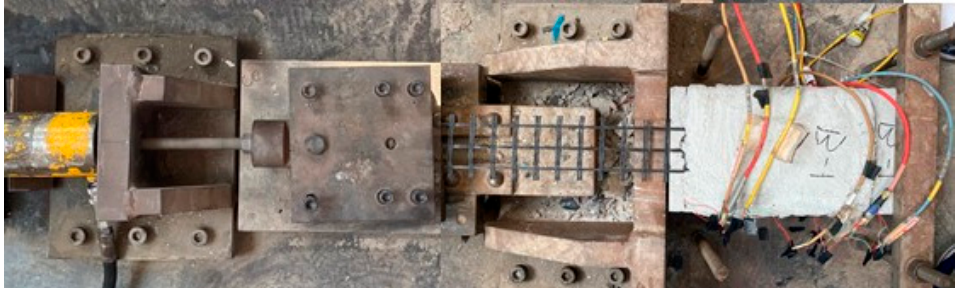
Figure 2. Test setup for single shear tests.